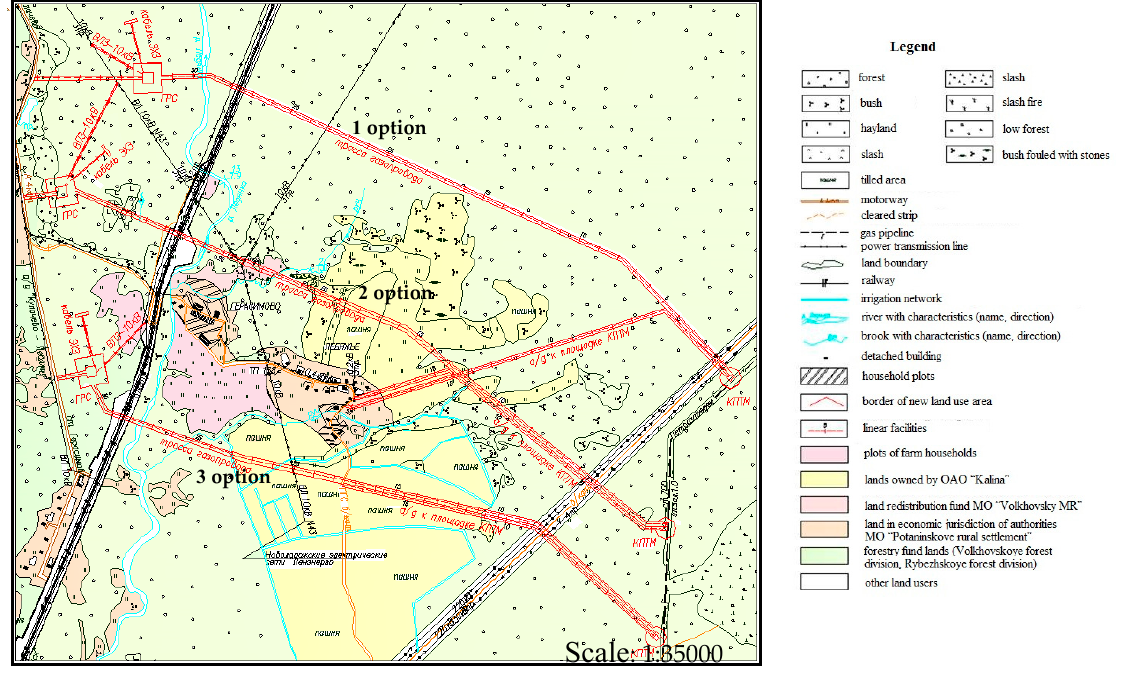
Figure 4. Options of gas pipeline layout.